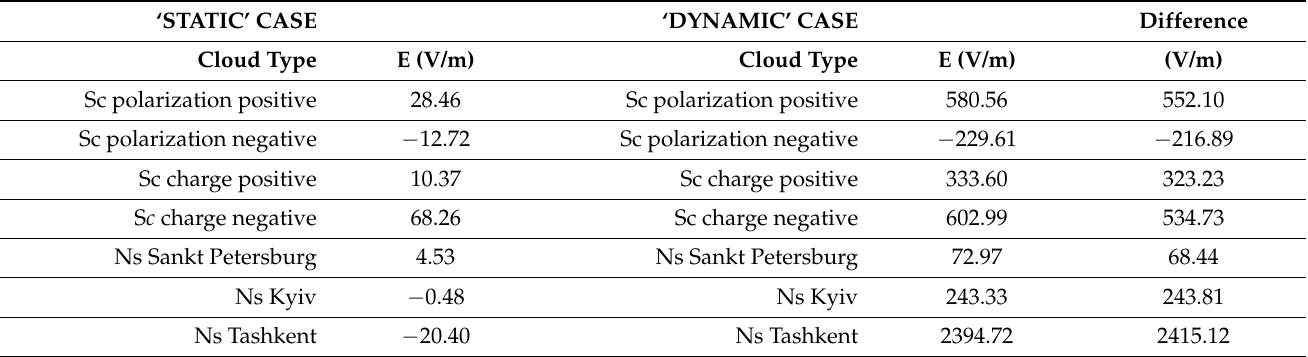
Table 1. The residual electric field strengths calculated for the moment of landing for different charge accumulation cases at the re-entry velocity of 15